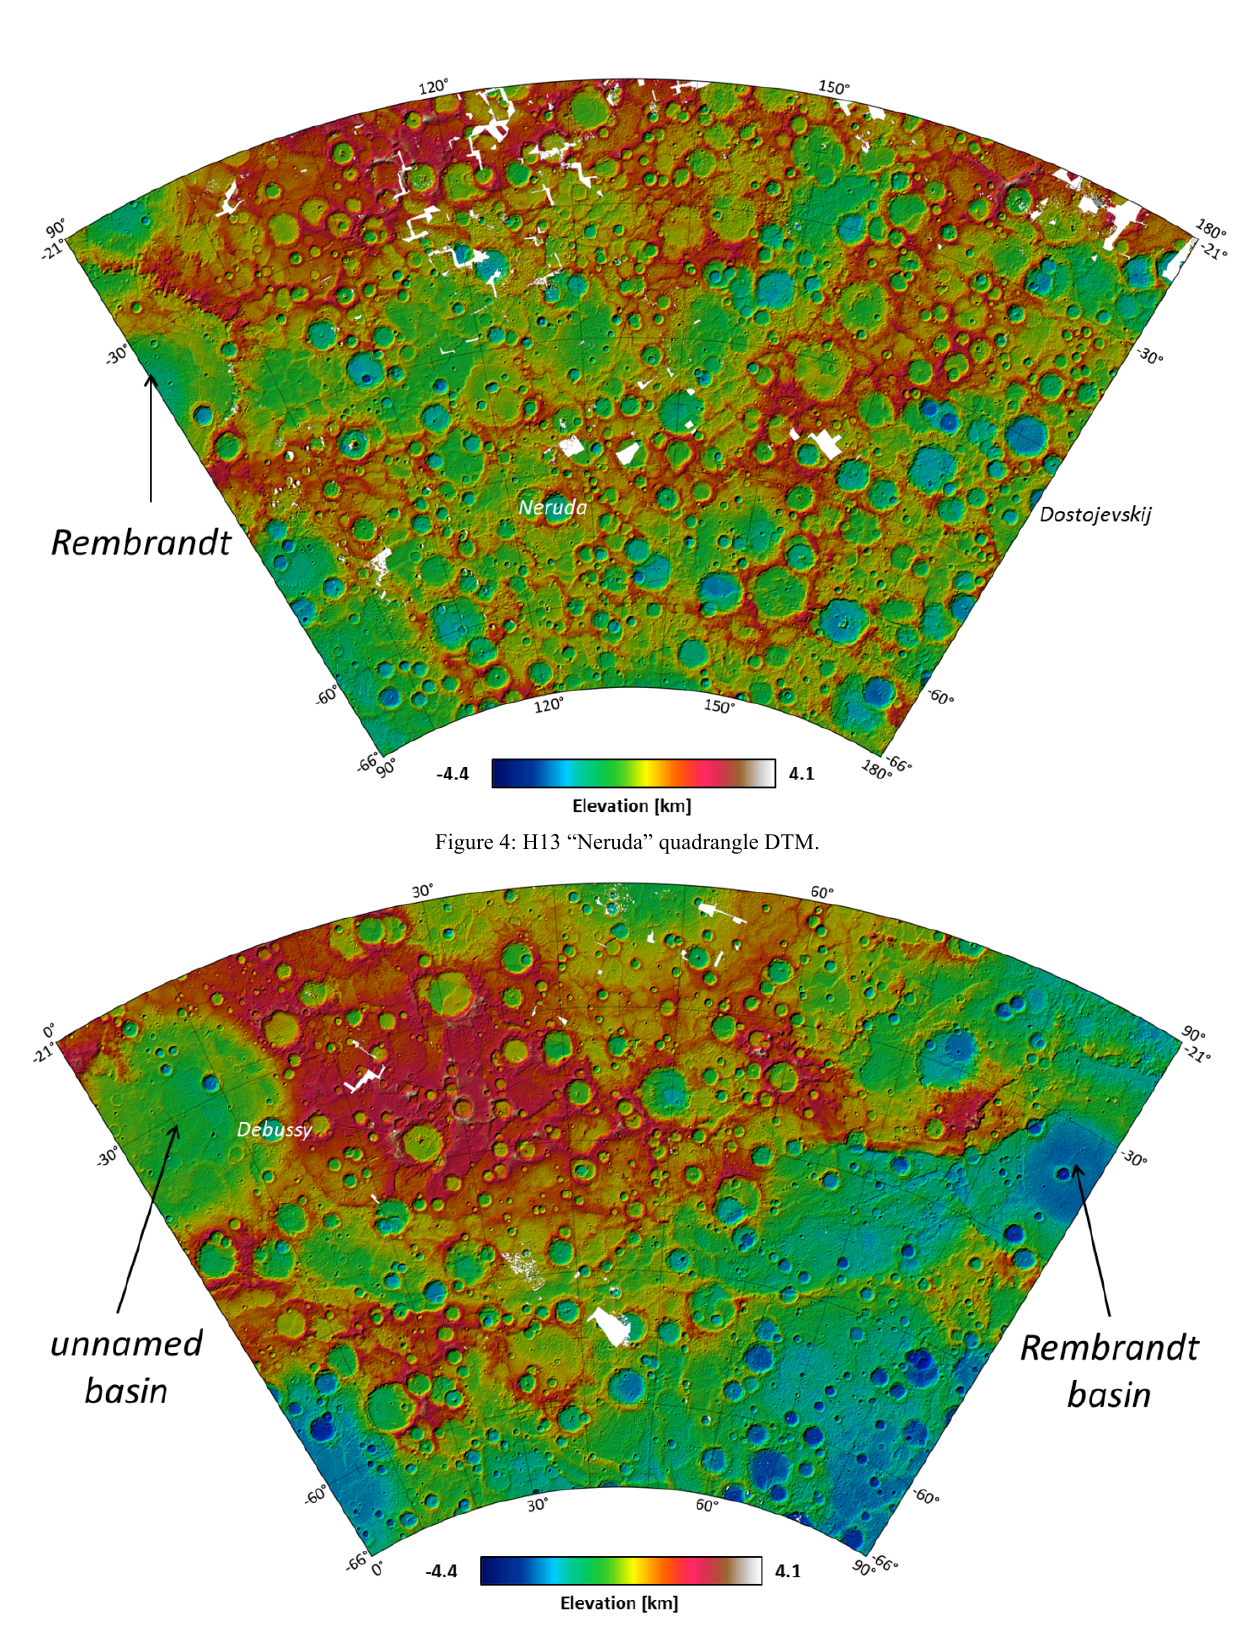
Figure 5: H14 “Debussy” quadrangle